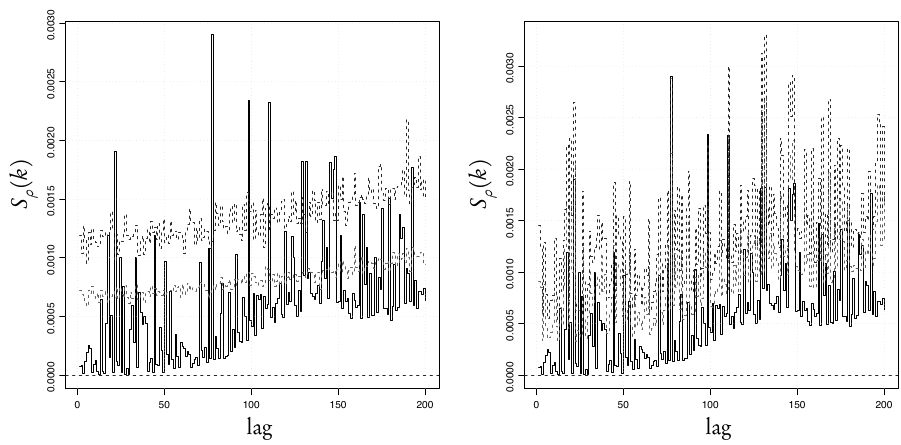
Figure 7 – S ( k ) , k = 1,...,200 for the hidden class of the anticodon sequence in frame U53218. ρ The confidence bands at 95% and 99% are indicated with (light and dark) gray dotted lines. The bands are obtained by permuting: (left) the whole sequence; (right) the first